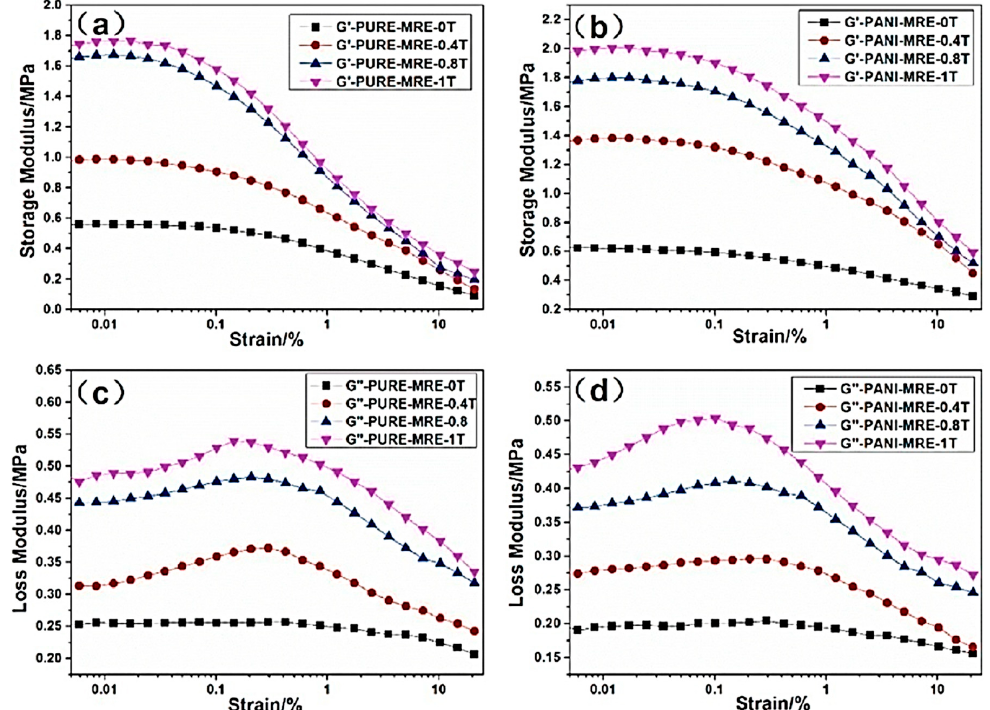
Figure 14. The plot of storage modulus: ( a ) pure MREs, ( b ) PANI-modified MREs, and loss modulus; ( c ) pure MREs and ( d ) PANI-modified MREs vs. strain under various magnetic flux densities [91] (reprinted with permission from Elsevier TM ).